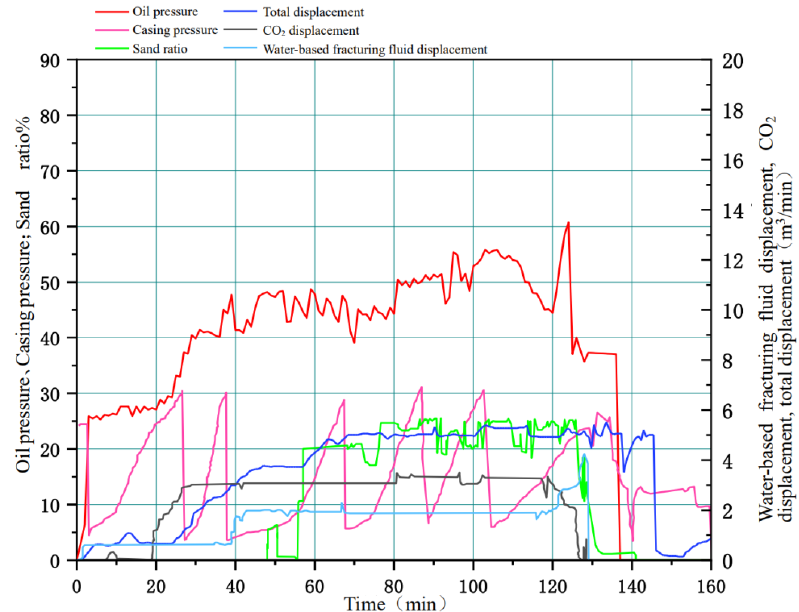
Figure 14. Fracturing construction parameters and construction curves.